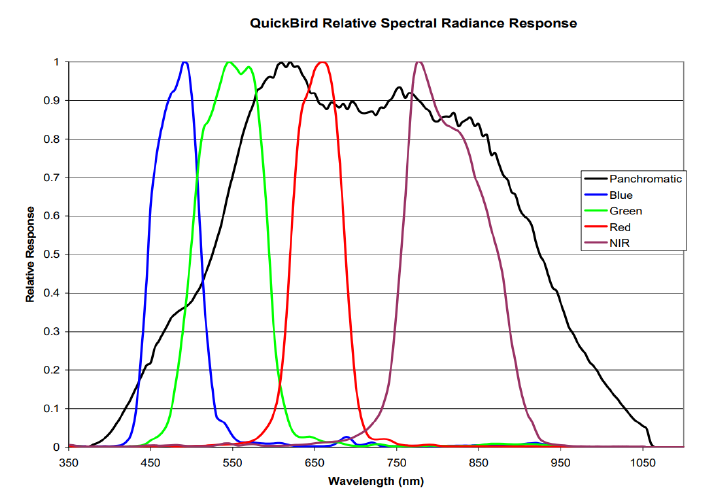
Figure 1. Spectral response of the QuickBird panchromatic and multispectral